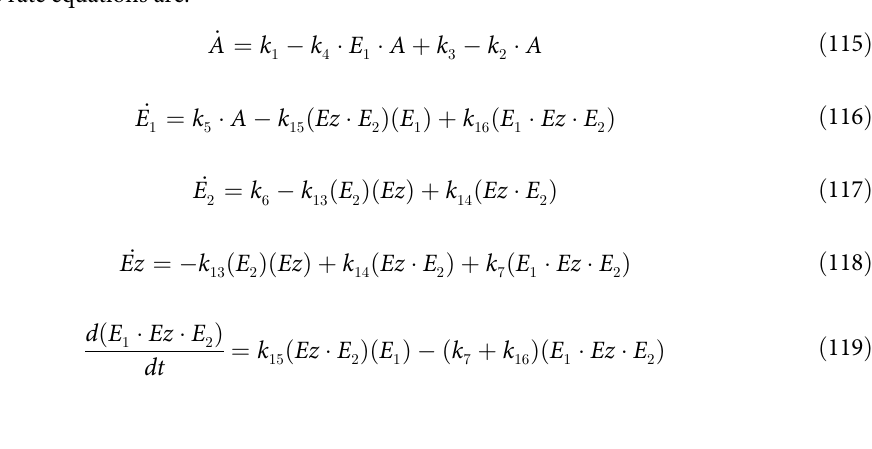
Fig 38. Switch between dual-E and single-E control in the m5 compulsory-order ternary-complex mechanisms ( E 1 binding first to Ez ) as a function of k 6 , k 9 , and k 11 . The total enzyme concentration is 1 × 10 − 6 and constant. (a) k 9 = k 11 =1 × 10 9 . A E controller is 2.5= k 7 � Ez tot / k 5 . (b) k 9 = k 11 =1 × 10 8 . Also in this case A set of the single-E controller is still close to 2.5. (c) k 9 = k 11 =1 × 10 6 . v ( _ P ) is no longer zero-order but is described by Eq 112, and A 10 2 and A single (cid:0) E =2.07. (d) k 9 = k 11 =1 × 10 5 . At single-E control conditions we have E 1 =4.82 × 10 2 and A single (cid:0) E ss rate constant values and initial concentrations as for Fig 37a.